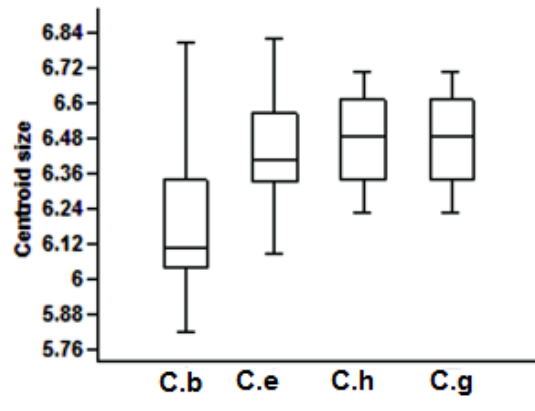
F IGURE 3. Boxplots for lower molar centroid size in the four species of Calomyscus , namely C.b: C. bailwardi , C.e: C . elburzensis , C.h: C. hotsoni and C.g: C . grandis . The mean and limits are indicated by the %95 confidence interval.